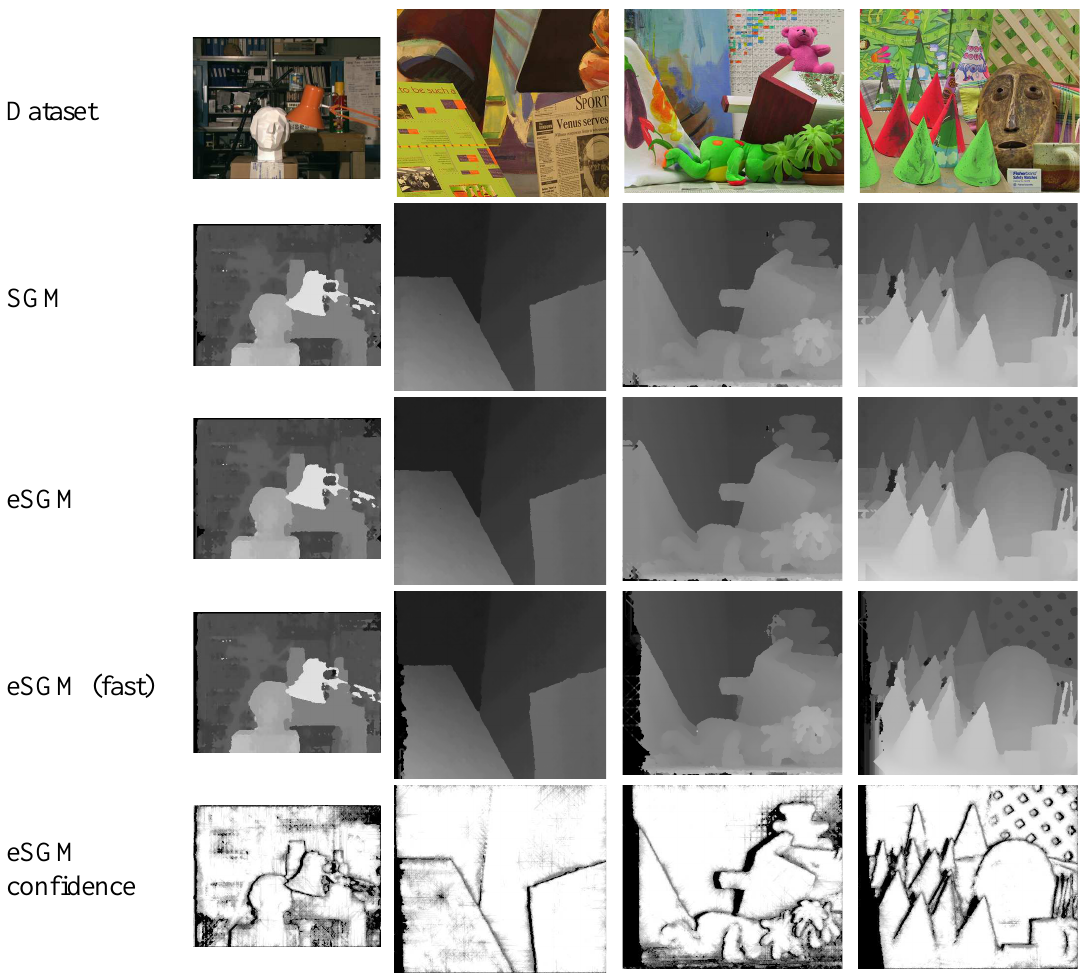
Figure 6: Comparison of our SGM and eSGM implementation on the Middlebury datasets.